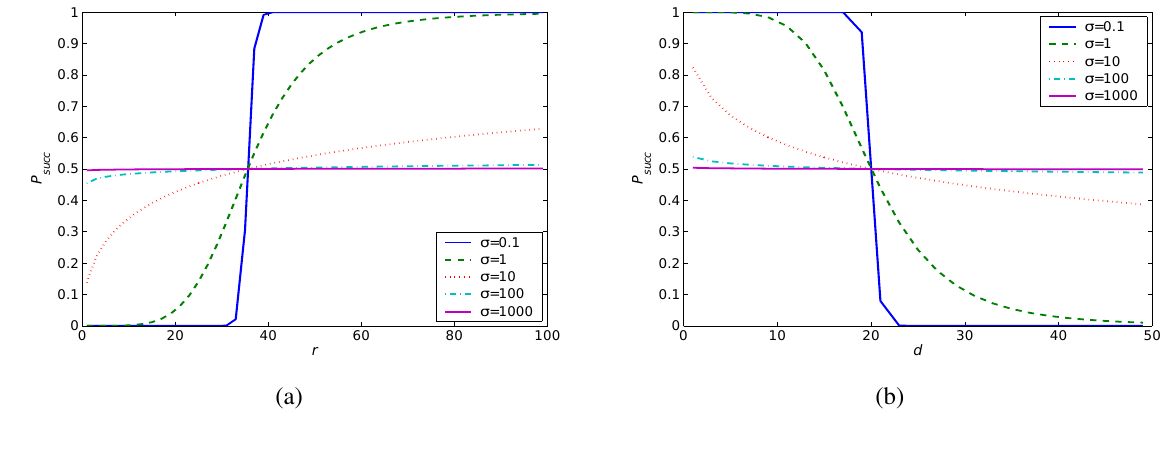
vs. r when d = 20 m. (b) P succ